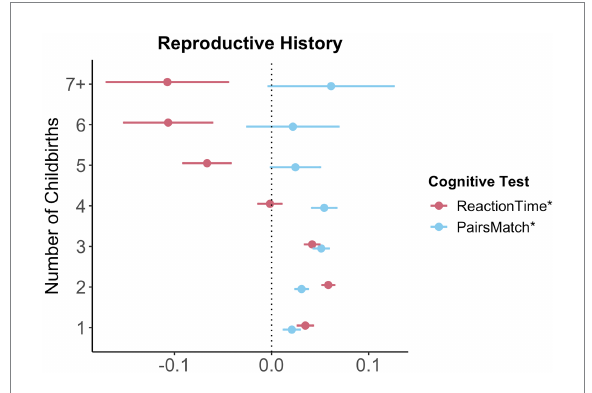
FIGURE 3 Significant non-linear association between number of childbirths and cognitive performance. Point plot of beta values with standard error from multiple regression analyses with cognitive task as dependent variable and number of childbirths as categorical independent variable. All models are adjusted for age, education, body mass index, Townsend deprivation score, and lifestyle score. All variables were standardized prior to performing the multiple linear regression analysis (subtracting the mean and dividing by the standard deviation). For visualization purposes, cognitive tests marked with * are inverted (multiplied by − 1) so that positive beta-values always indicate associations between higher values on the female-specific variables and better performance on cognitive tests. Sample size for Pair Matching (0 = 34,881, 1 = 23,387, 2 = 77,687, 3 = 30,478, 4 = 7,596, 5 = 1,569, 6 = 446, 7+ = 234). Sample size for Reaction Time (0 = 34,699, 1 = 23,232, 2 = 77,308, 3 = 30,262, 4 = 7,520, 5 = 1,545, 6 = 430, 7+ =